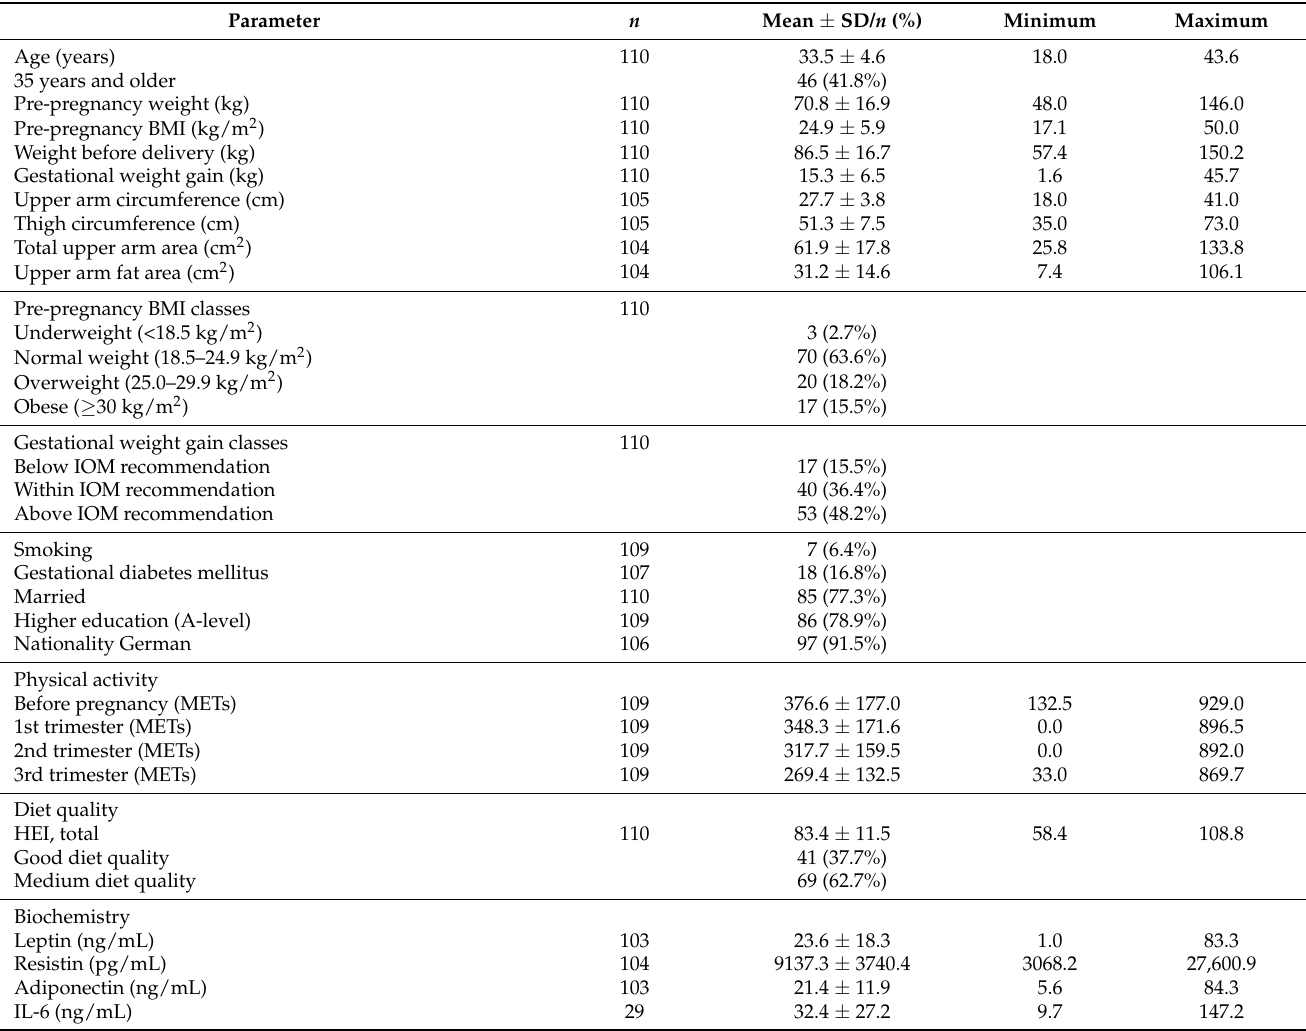
Table 2. Participants’ characteristics (mean ± SD/ n (%)).